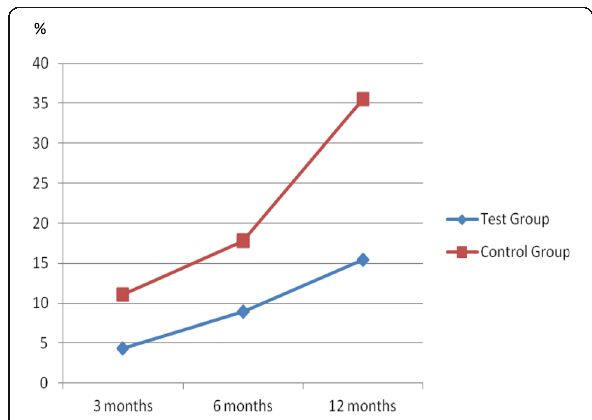
Fig. 2 Cumulative changes over time in the percentage incidence of episodes of recurrent cystitis in the two treatment